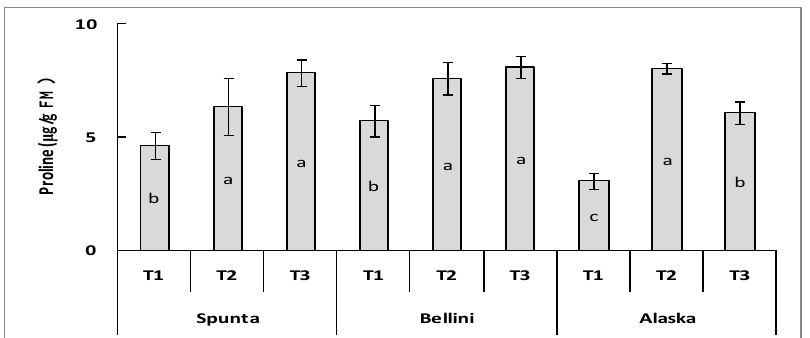
Figure 1. Changes in proline content of potato varieties under each irrigation treatment. Different letters indicate significant difference between treatments according to Duncan test ( p ≤ 0.05). T1: